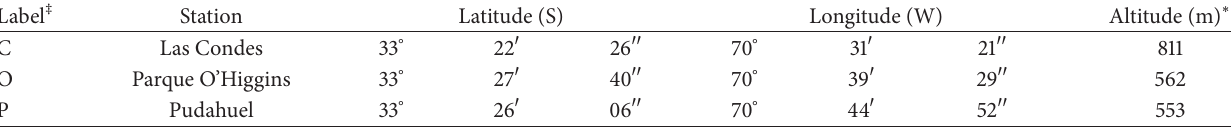
‡ Labels are according to Figure 1. ∗ Above sea